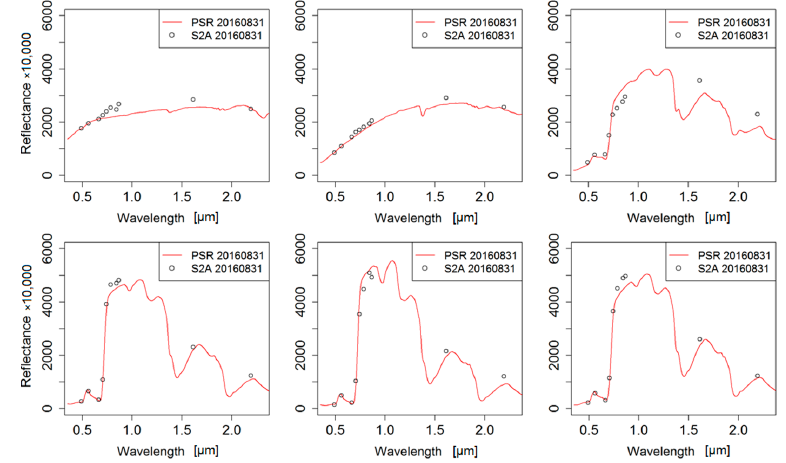
Figure 9. Comparison between field spectral measurements on 31 August and Sentinel-2 data acquired on the same day (Sentinel-2 tile 33UXP) from upper left to lower right: asphalt, bare soil, crop residue, two soya fields at different phenological stages, and meadow. Reflectance values are scaled by 10,000.